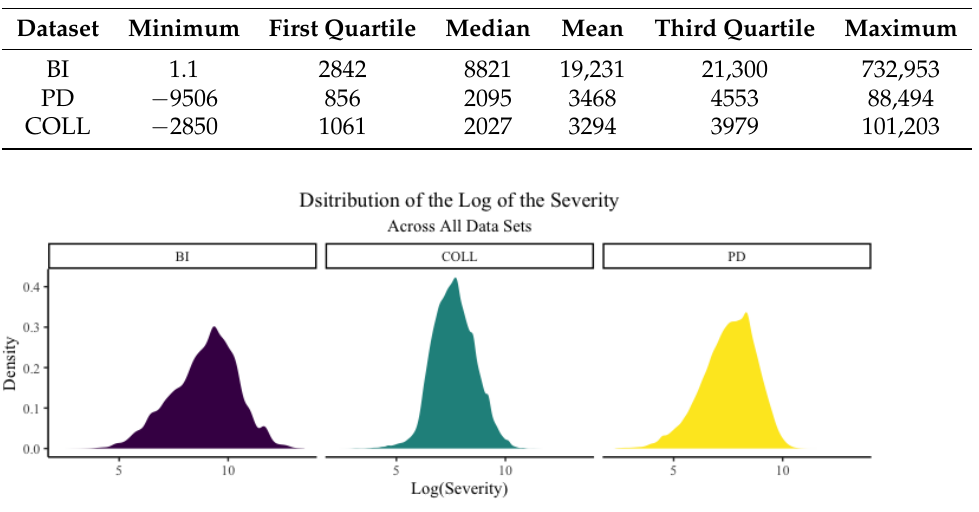
Table 5. Summary statistics for the severity for each dataset.